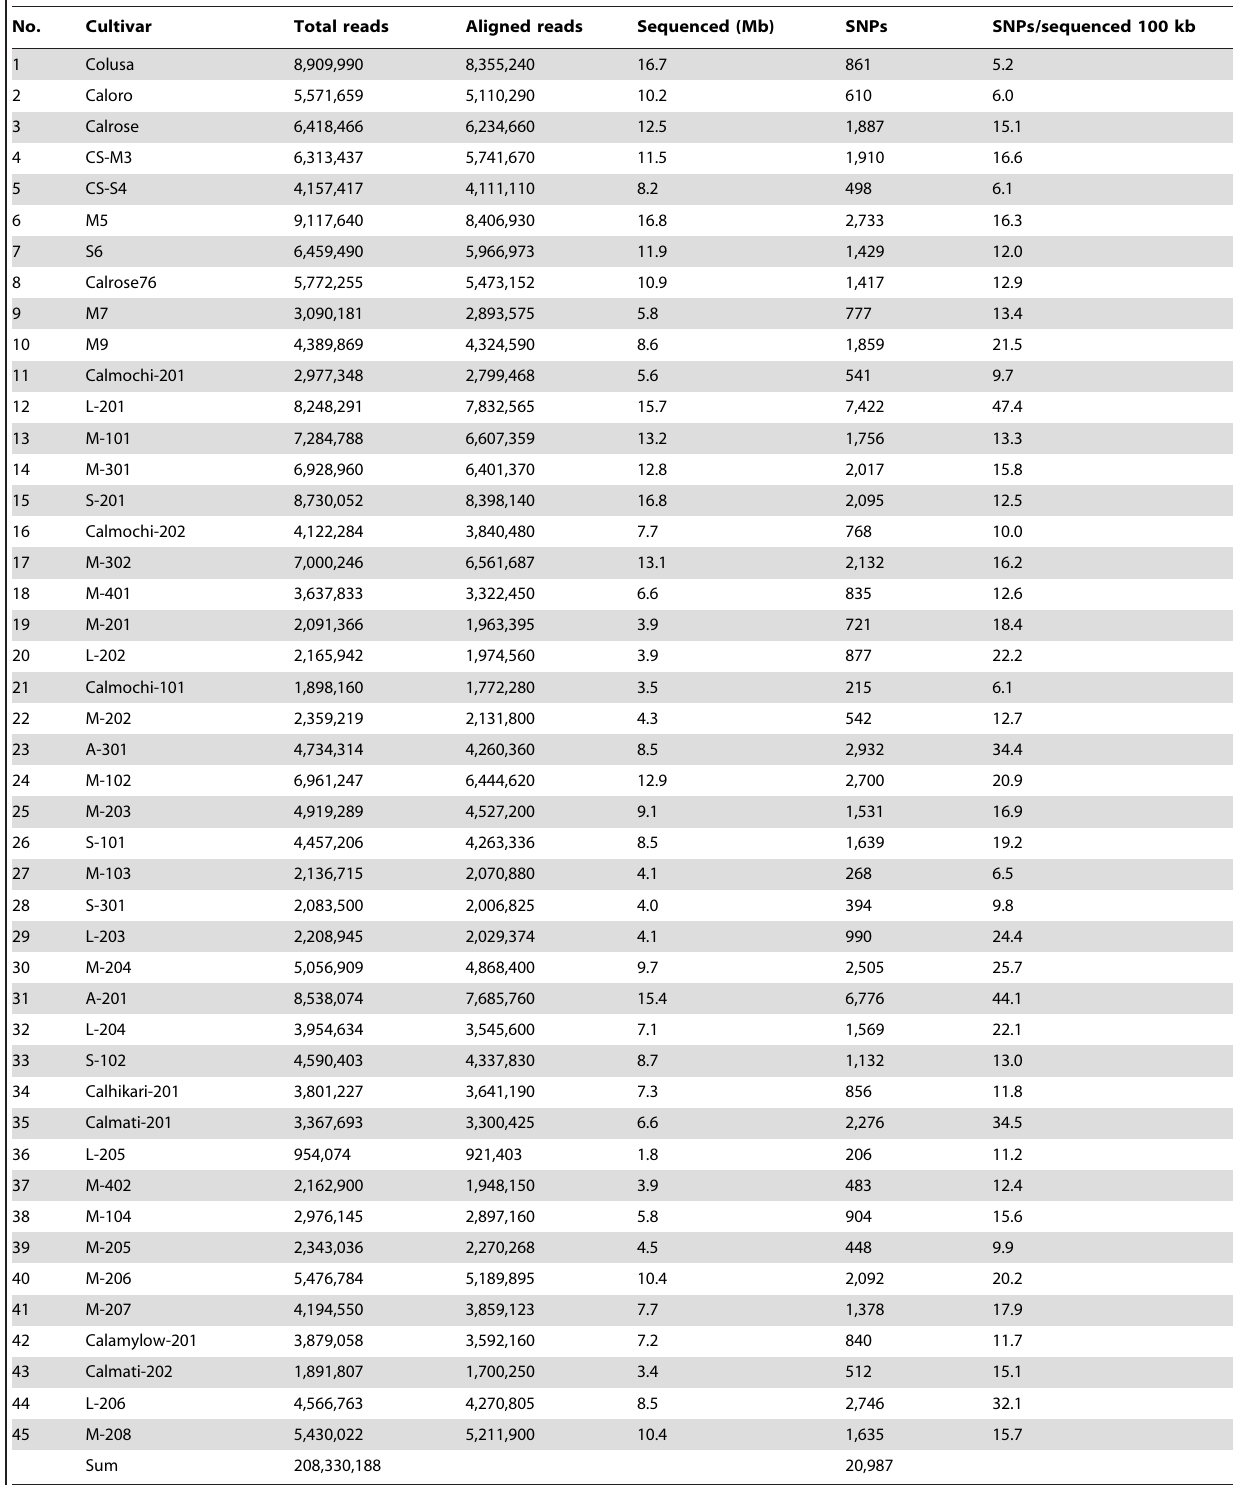
Table 1. Sequencing results for forty five California